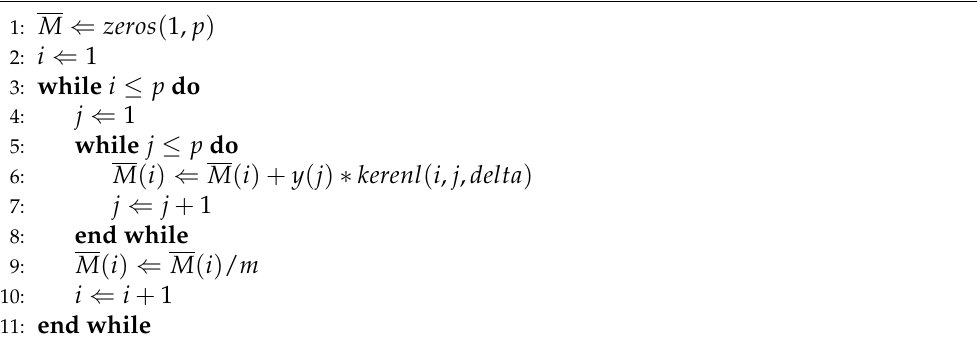
Algorithm 5 Calculate M = RowAverage ( p , kernel , delta , m , y